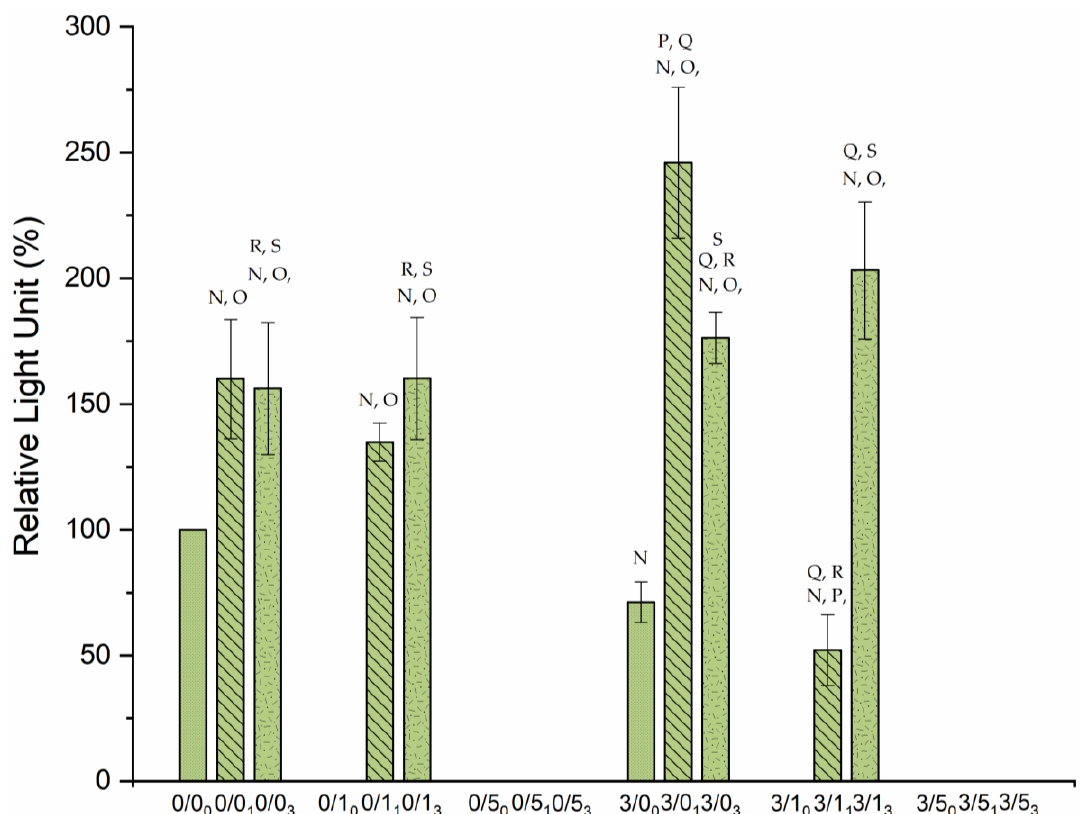
Figure 7. Biofilm viability results created on PLA film in percentage of relative light units. The smooth bars are for non-degraded samples, the diagonally hatched bars are for the samples degraded for one month, and the notched bars are for the samples degraded for 3 months. Statistical difference ( p < 0.05) is marked with the different letters depending on which sample it is compared with. The letters N is used to 0/0 0 ; O is used to 3/0 0 ; P is used to 0/0 1 ; Q is used to 0/1 1 ; R is used to 3/0 1 ; S is used to 3/1 1 .